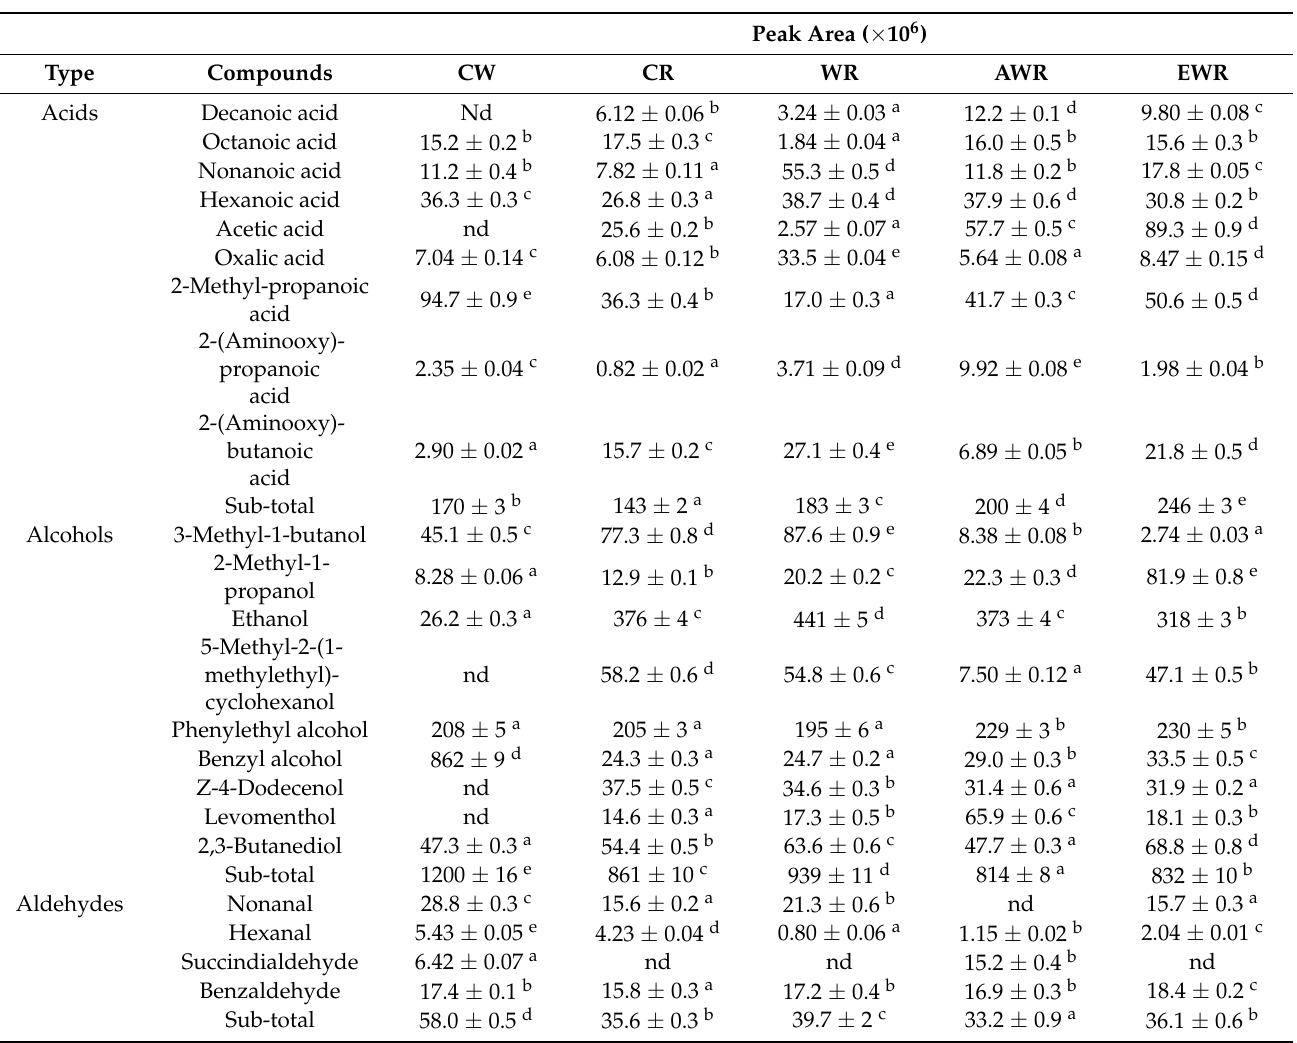
Table 4. Volatile compounds of red bean sourdough bread and the respective